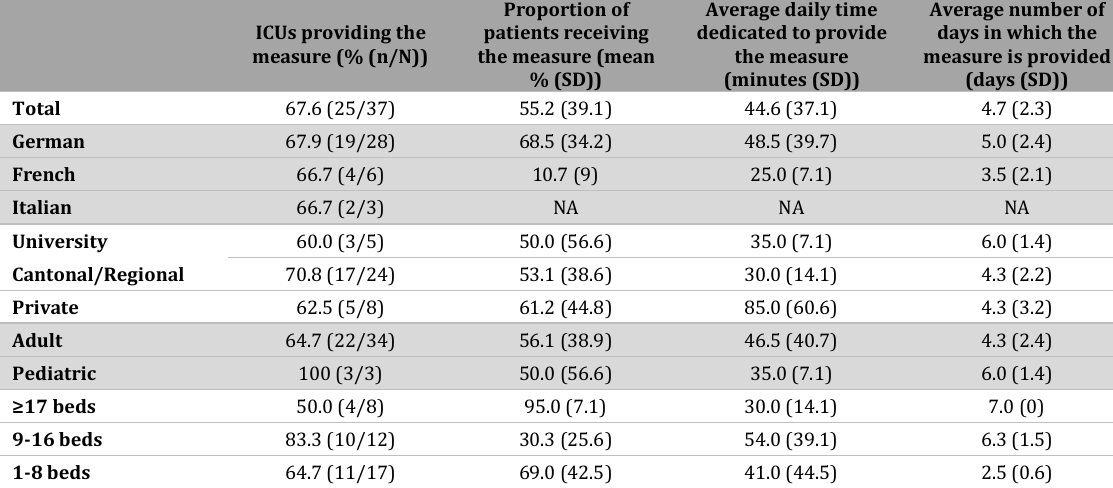
Table S12. Other active exercises in bed